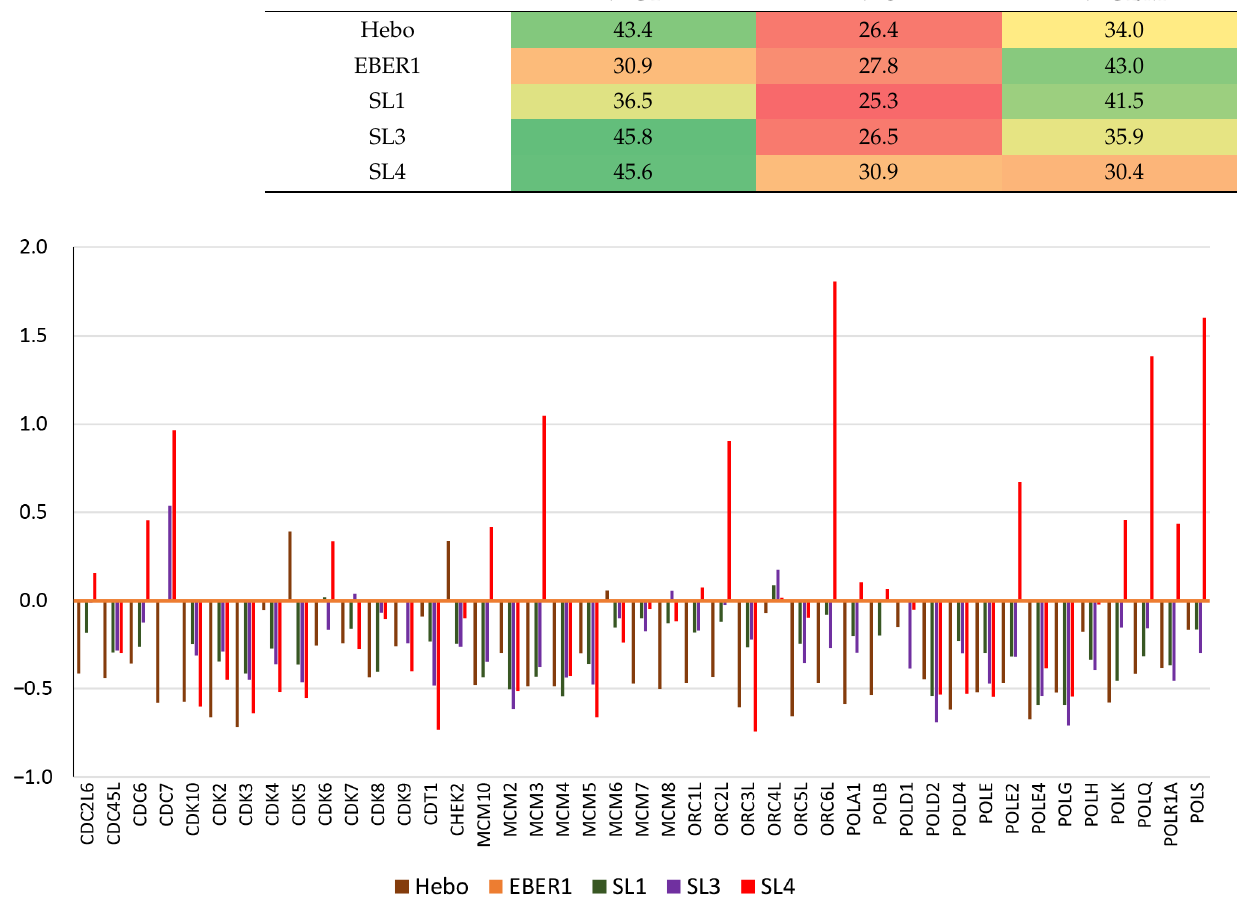
Figure 7. Analysis of genes involved in cell cycle and proliferation . Total cellular RNA was isolated using TRIzol method, and a total of 5 µg was reverse transcribed to cDNA. A total of 43 genes associated with human cell cycle and chromosomal replication were quantified using qPCR-based microarray plate. There was no gene observed to be up to 1-fold decreased. ∆SL4 cells showed upregulation in some genes. EBER1 wildtype is set at 0.0 as reference. Experiments were performed in duplicate. Data are presented as mean of two experiments.